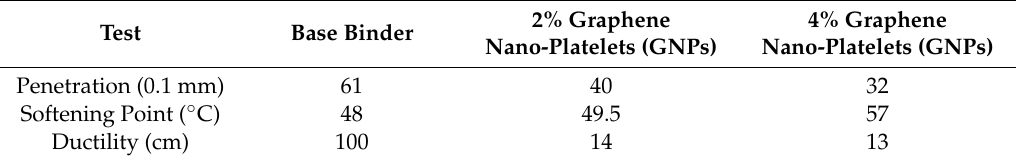
Table 5. The physical properties of the base and modified